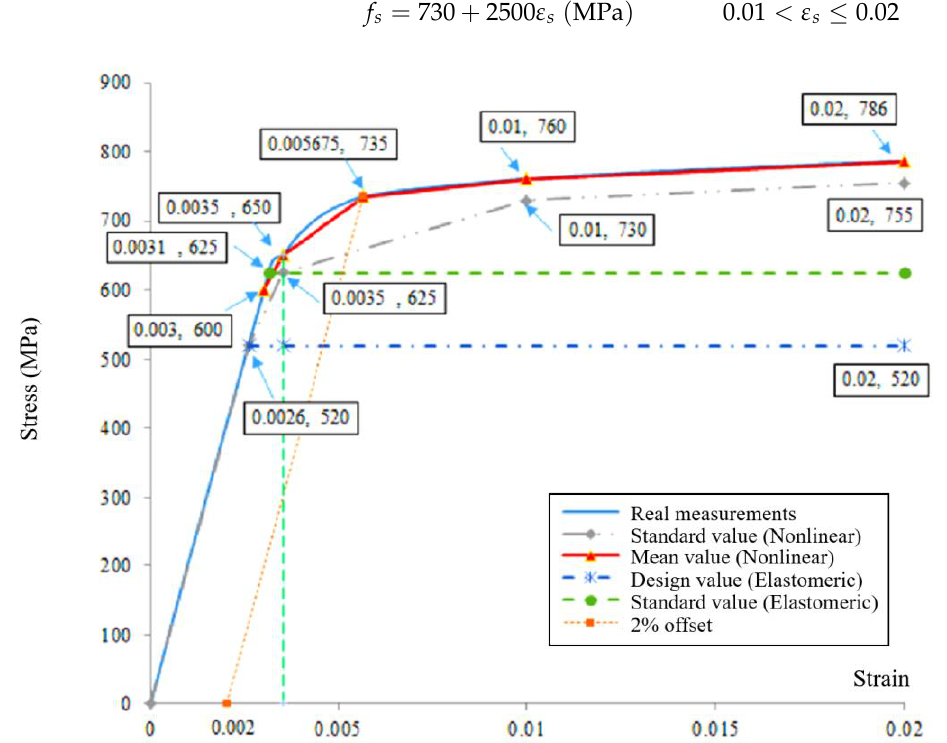
Figure 3. Simplified model of the stress-strain relationship for CRB735.